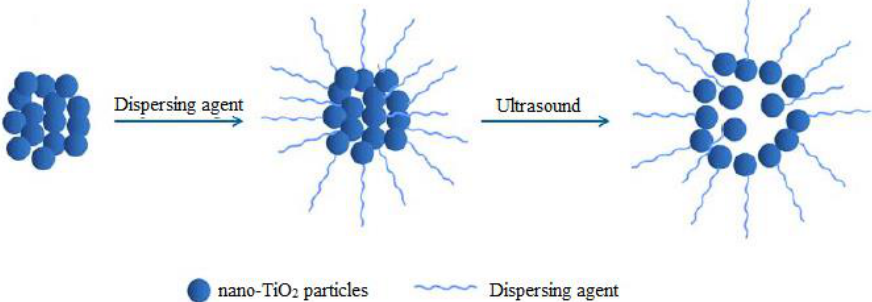
Figure 17. An illustration of ultrasonic dispersion of nano-TiO 2 [31].